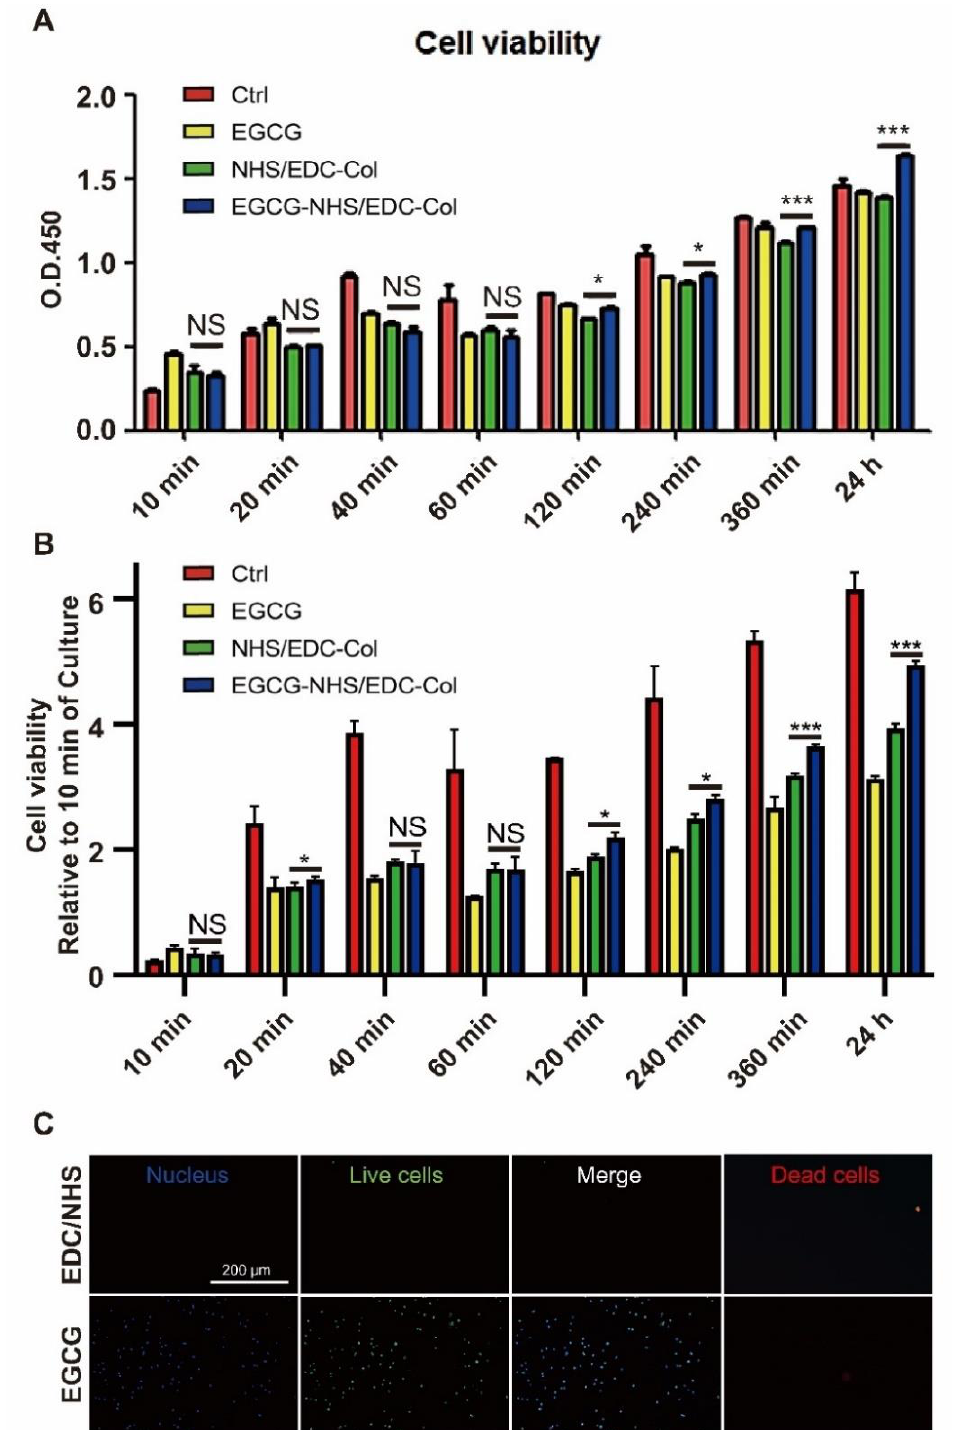
Figure 4. CCK-8 results ( A ), CCK-8 relative to 10 min results ( B ), and Calcein AM/Hoechst staining ( C ) of Raw 264.7 cultured on different conditions. Ctrl, standard medium; EGCG, 0.064% EGCG supplemented medium; EDC/NHS-Col, EDC/NHS collagen membrane; EGCG-EDC/NHS-Col, 0.064% EGCG-EDC/NHS collagen membrane. Green, live cells; blue, nucleus; red, dead cells. NS = no significance, * p < 0.05, *** p < 0.001, one-way ANOVA with Tukey’s multiple comparison testing, n = 3 in each group.